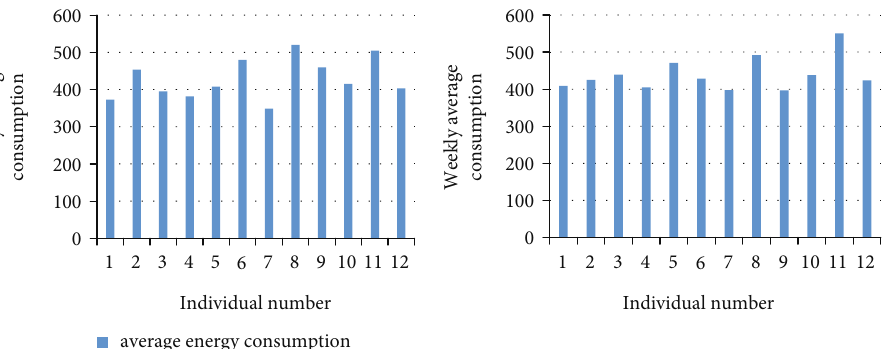
Figure 7: Average energy consumption of class A over two weeks.